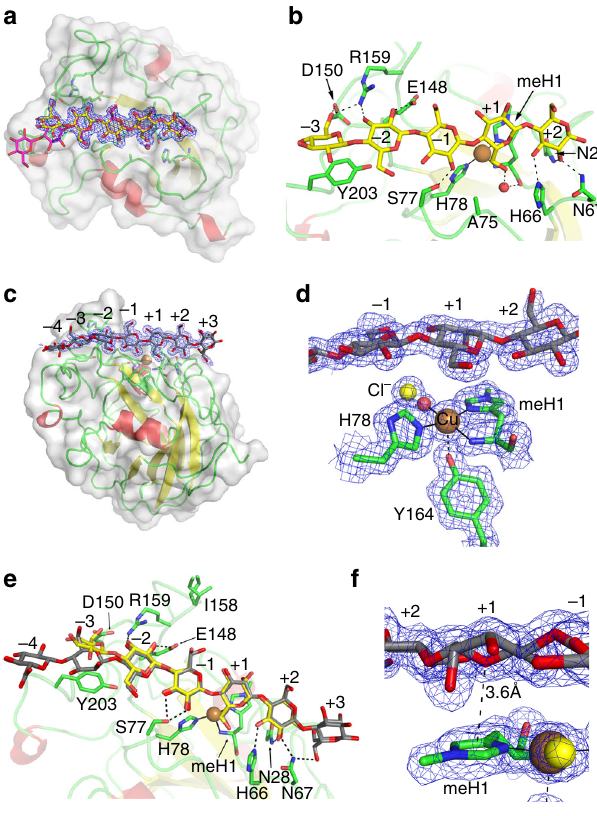
Fig. 5 Structures of Ls AA9A:Cell 5 and Ls AA9A:glucomannan oligosaccharide complexes. a Cell 5 (yellow) is well de fi ned in subsites – 3 to +2. A 2 F obs − F calc electron density map is shown at 1 σ contour level. The structure shows no crystal contact induced distortion of the Cell 5 substrate when compared to Cell 6 (magenta). b , Ls AA9A-Cell 5 interactions are shown as dashes. An additional interaction between subsite – 3 O6 and Asp150 is gained in the absence of symmetry related contacts to the substrate. c Overall structure of Ls AA9A with GM (grey) bound from subsite − 4 to +3. d Close-up (subsite – 1 to +2) of the active site with GM fragment bound. Axial coordinations are in black dashes while equatorial coordinations are in full black lines. e Top-down view of Ls AA9A:GM (GM in grey) and for comparison Ls AA9A:Cell 5 (Cell 5 in yellow). Dashed lines show interactions within hydrogen bond distance (2.8 Å). f The C2- hydroxyl of mannose is clearly visible in the density at subsite +1. The pyranose O5-imidazole ring interaction (3.6 Å) is indicated with dashes. The interaction of MeHis and the mannosyl residue is very similar to the interaction with glucosyl residues in previous complexes 38 . A 2 F obs − F calc electron density map is shown at 1 σ contour level for panels a , d and